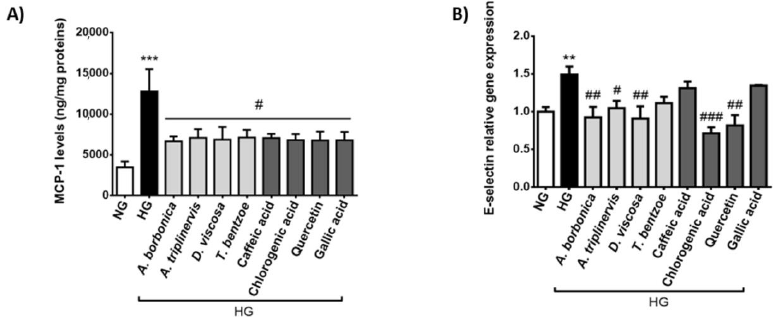
Figure 4. Effect of hyperglycemic condition and polyphenols on markers involved in endothelial cell and leukocyte interaction. Cells were exposed to normoglycemic condition (NG) or hyper- glycemic condition (HG) in presence or not of each polyphenol-rich plant extract (10 µ M GAE) or a pure polyphenol (10 µ M). The secretion of MCP-1 was measured by ELISA kit ( A ). The expres- sion of E-selectin gene was measured by RT-qPCR and normalized to GAPDH gene expression ( B ). Data are means ± SEM of three independent experiments (three cellular passages). **: p < 0.01 and ***: p < 0.005 as compared to NG; # : p < 0.05, ## : p < 0.01 and ### : p < 0.005 as compared to